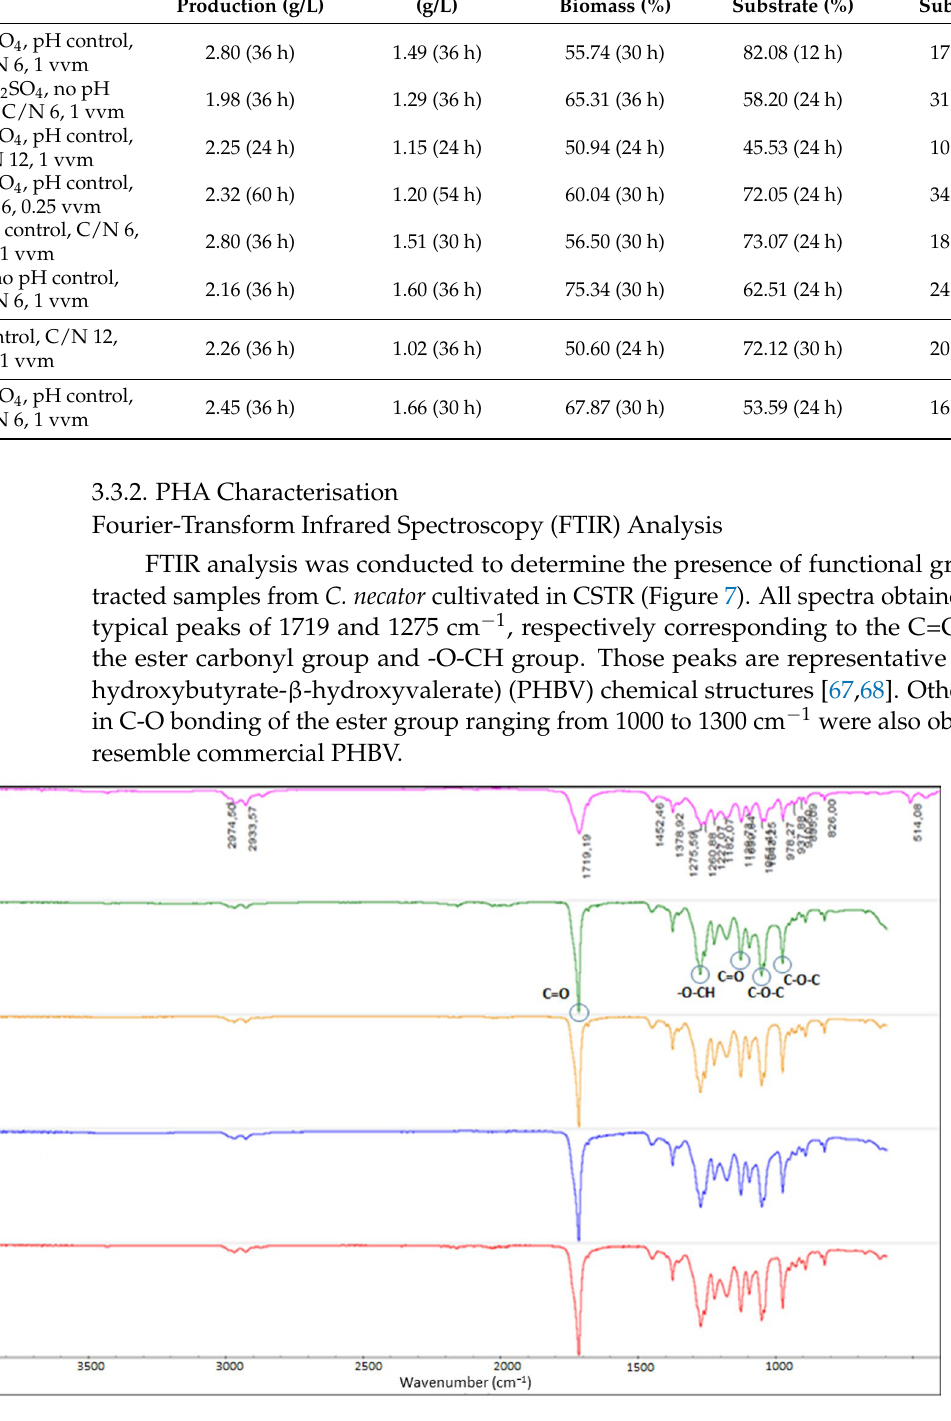
Figure 7. Fourier Transform Infrared Spectroscopy (FTIR) spectra from extracted